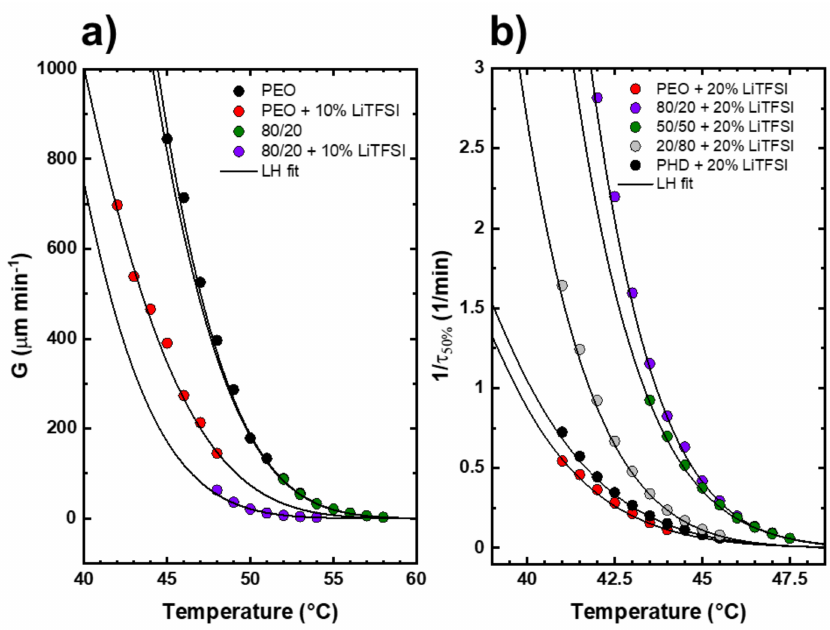
Figure 6. ( a ) Spherulitic growth rate of PEO and 80/20 PEO/PHD blends with and without 10% LiTFSI, ( b ) Overall crystallization rate of homopolymers and blends with 20 wt%